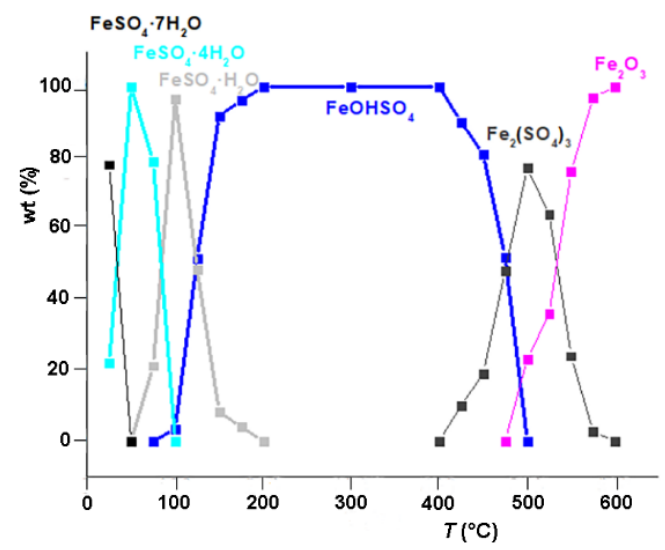
Figure 7. Evolution of the phase amounts refined from the Rietveld method based on the powder X-ray diffraction patterns in the temperature range RT-600 °C.